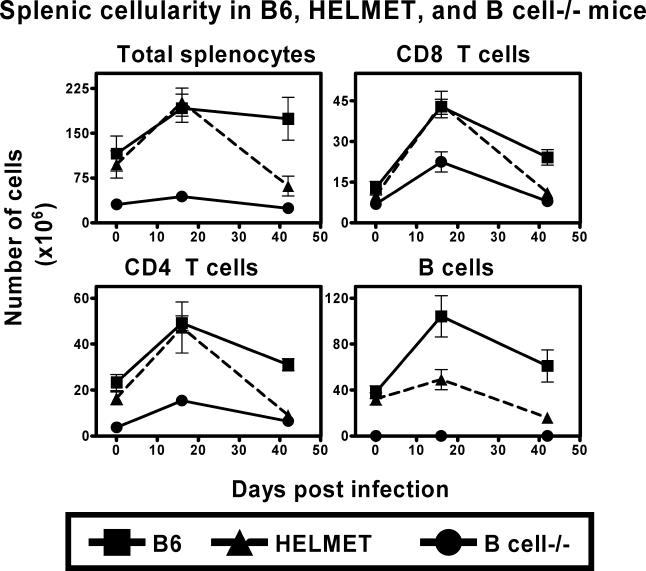
HEL-Specific B Cells Normalize Some but Not All Abnormalities in Splenic Cellularity Observed in B Cell−/− MiceSplenocytes from pooled naïve or mock infected and γHV68 infected B6, HELMET, and B cell−/− mice were counted and stained with antibodies against CD8, CD4, and CD19. The splenocyte numbers were the same in naïve and mock-infected mice, and data from mock infected and naïve mice were pooled. Numbers represent number of cells/spleen × 106. The data are pooled from two to six independent experiments evaluating three to five mice per experiment.